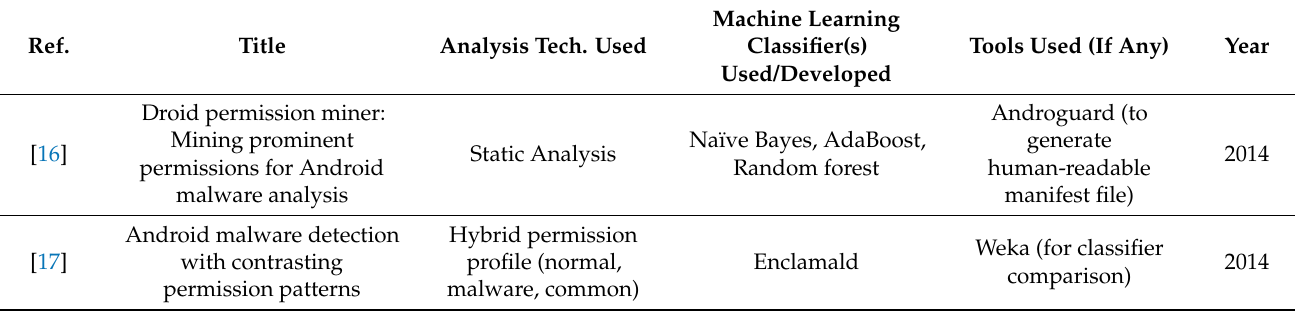
Table 2. Selected primary study papers.